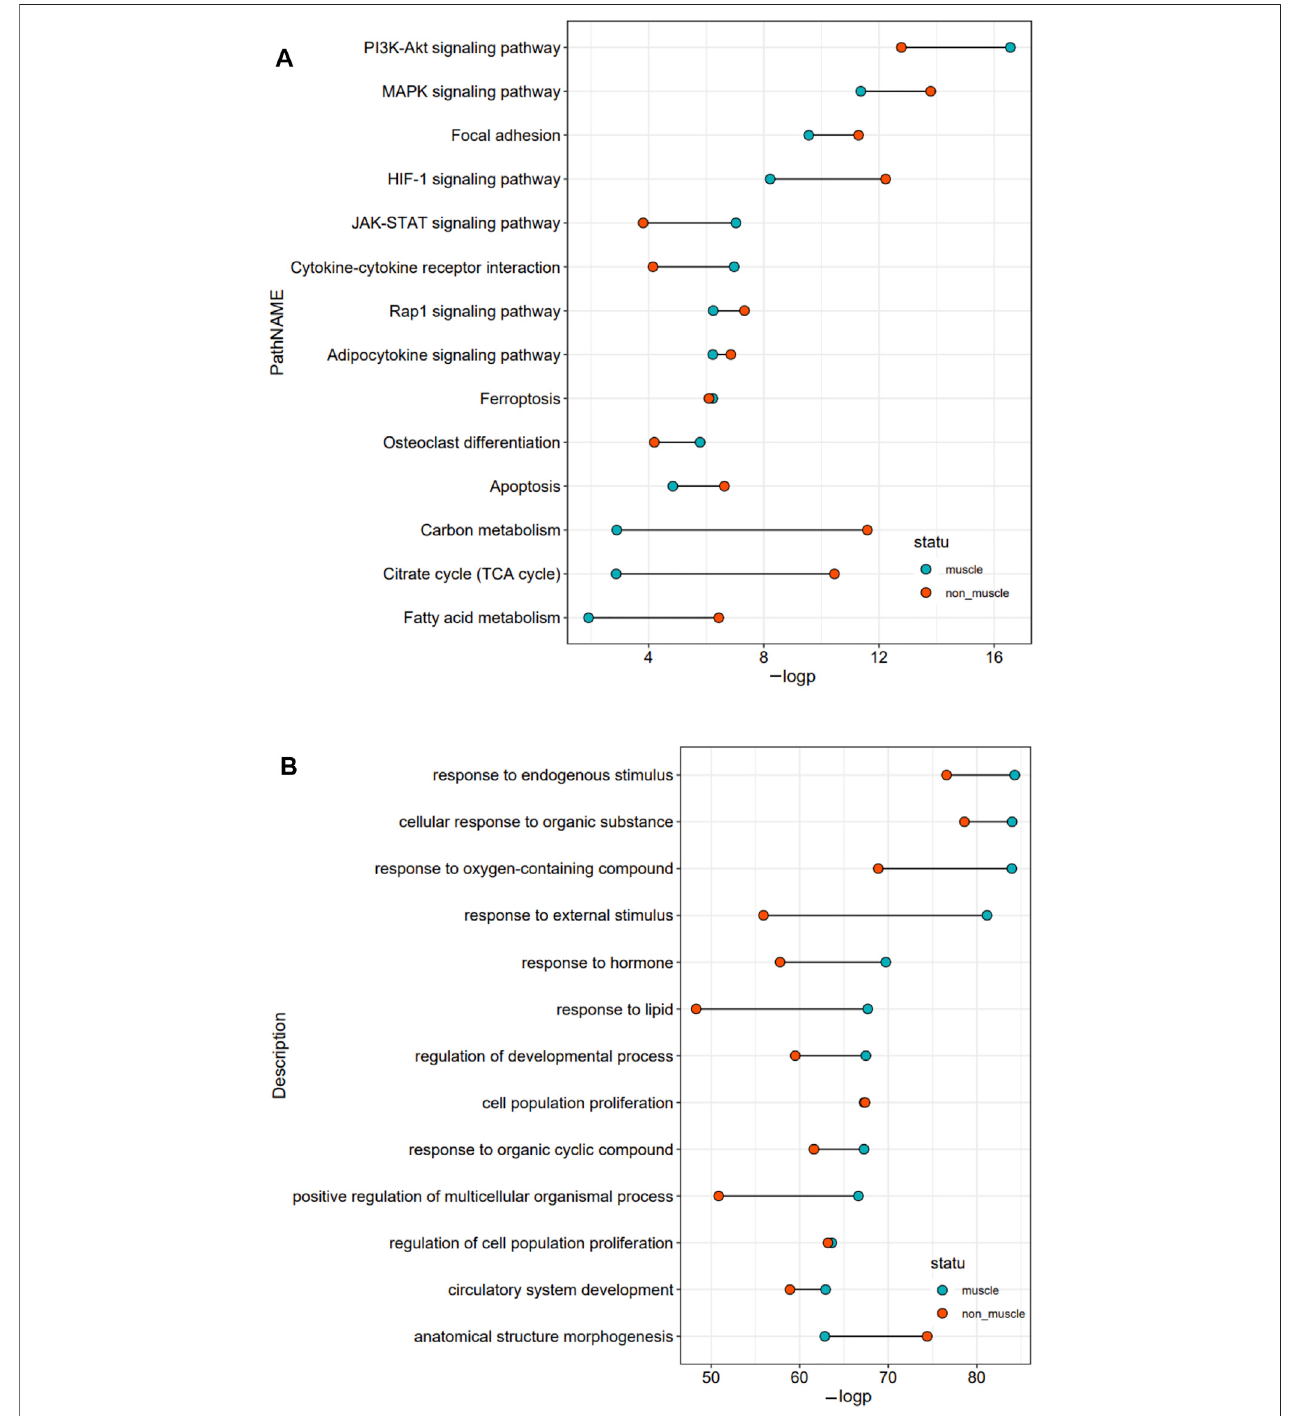
FIGURE4| FunctionalcomparisonoftargetgenesofdifferentiallyexpressedTFsrelatedandunrelatedtothepathophysiologyofskeletalmuscle. (A) Theunionset of top 10 pathways in the two groups. (B) The union set of top 10 biological processes in the two groups.